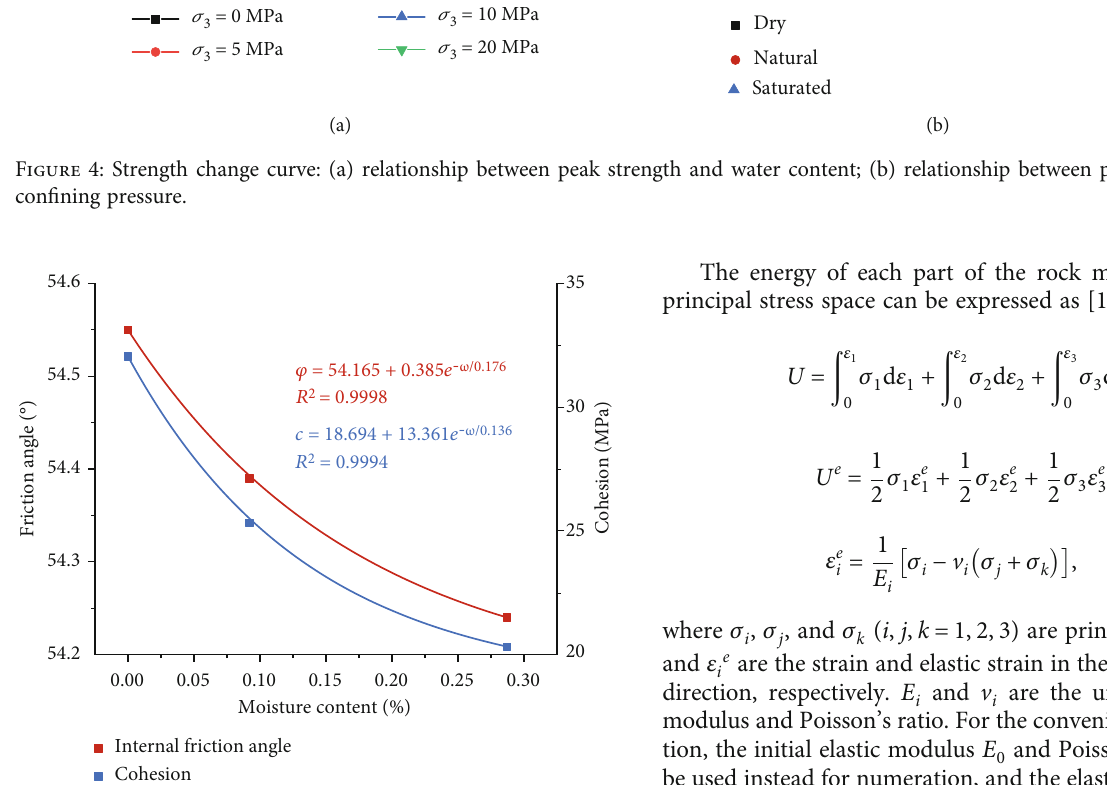
Figure 5: Relationship of cohesion and internal friction angle with water